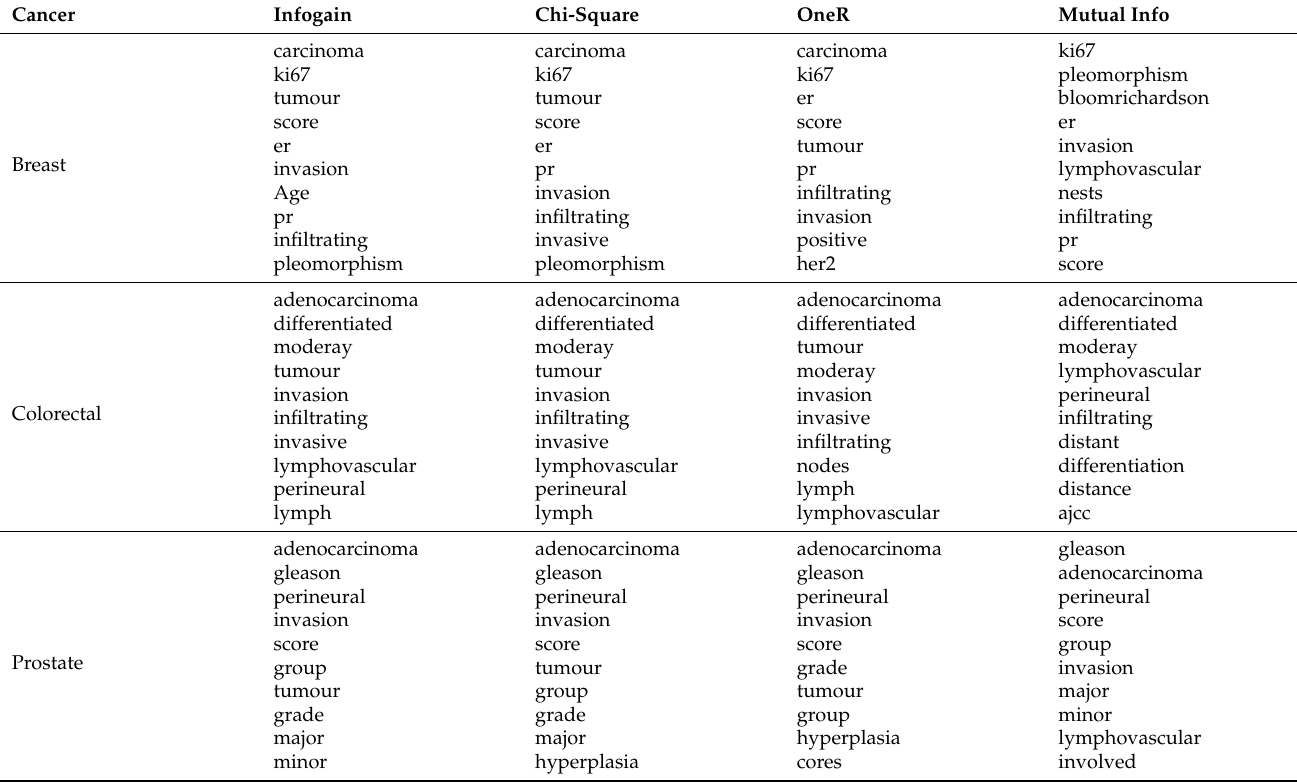
Table 2. Top ten key features or terms identified from each feature selection methods for breast, colorectal, and prostate cancers.